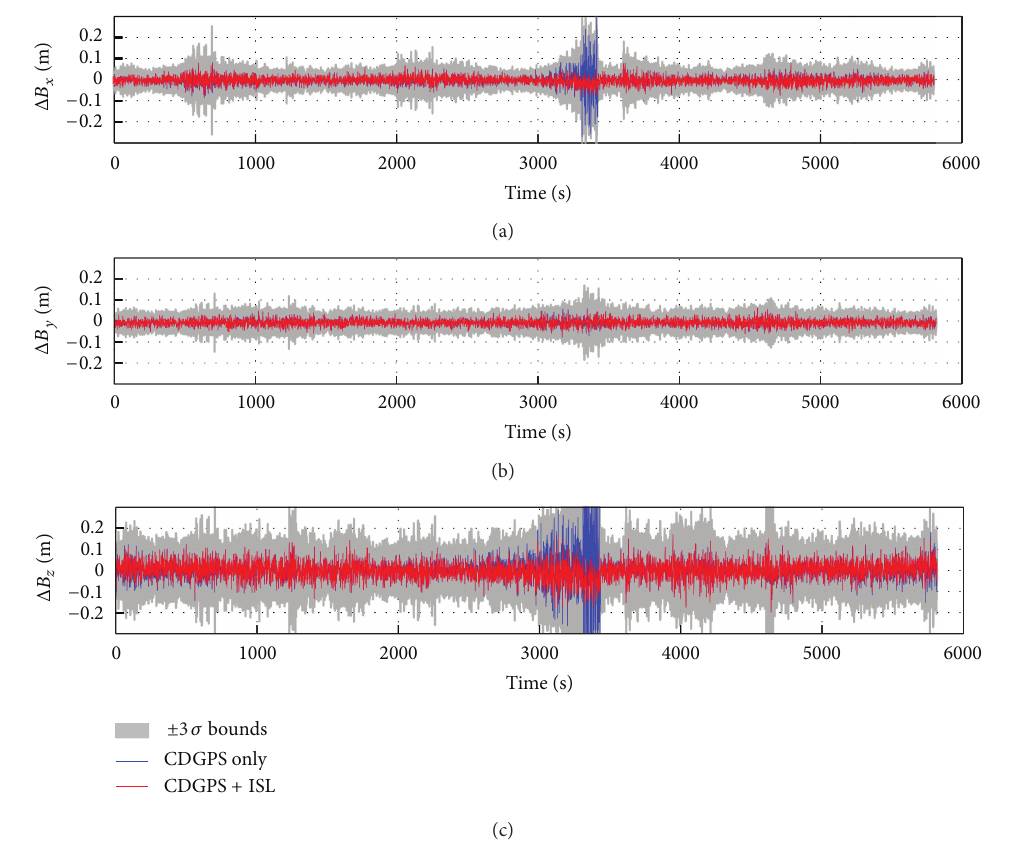
Figure 6: ORF baseline components error (the first case); ±3𝜎 bounds are relevant to CDGPS +